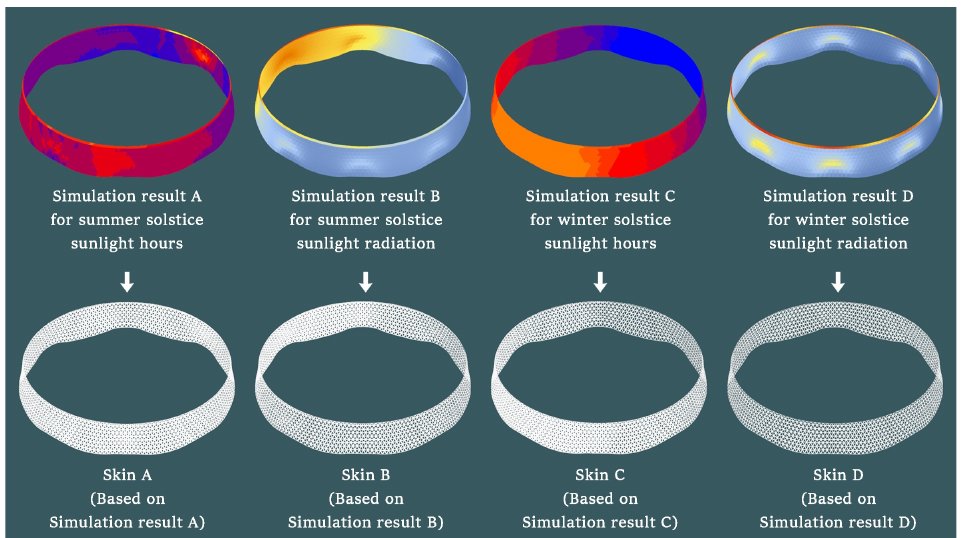
Figure 11. ( a ) Photothermal data of skin interference method and ( b ) effect of skin cell change (self-developed).